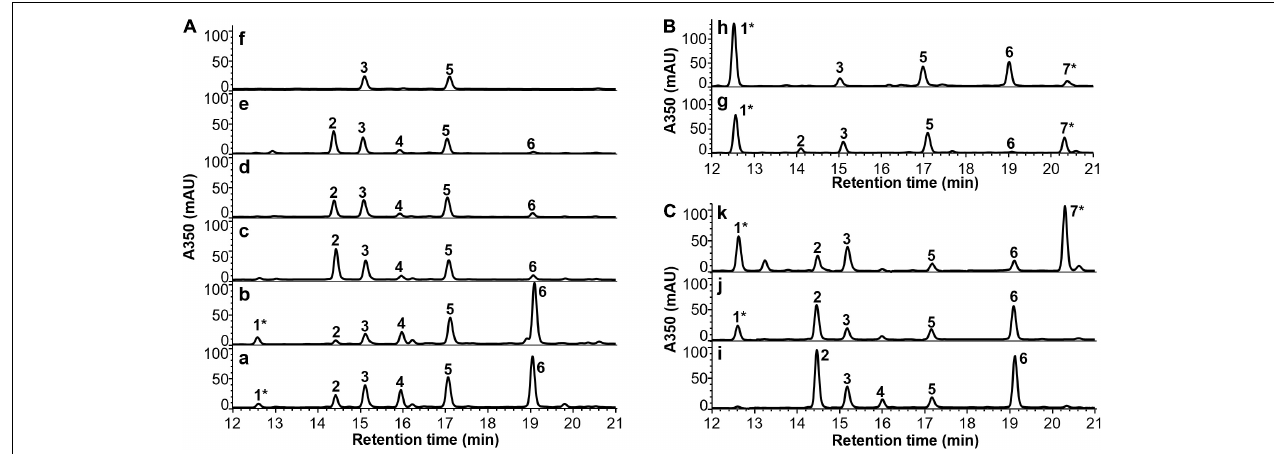
FIGURE 2 | HPLC-DAD chromatograms of cell extracts of P. freudenreichii grown in CDM or CDMG under different cultivation schemes indicated on the upper left corner (details in Table 2 ). The identities of the numbered peaks were determined by comparing to the standards of OHCbl (1) and AdoCbl (7) or by UHPLC-QTOF-MS in terms of AdoCbi-GDP (2), FAD (3), AdoCbi-P (4), FMN (5) and AdoCbi (6) (see Supplementary Figures 1–6 ). (A) P. freudenreichii grown in CDM following cultivation schemes a–f. (B) P. freudenreichii grown in CDM with the addition of DMB before and after semi-anaerobic incubation following cultivation schemes g and h, respectively. (C) P. freudenreichii grown in CDMG following cultivation schemes i–k. Asterisk* indicates intact cobalamin structures.